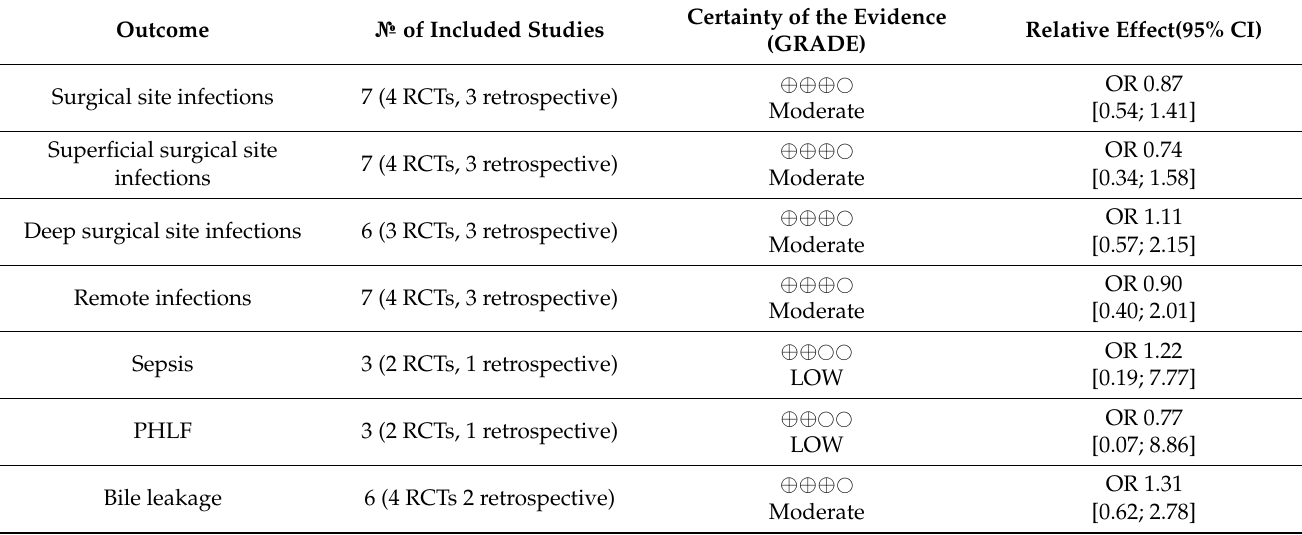
Table 5. Certainty of the evidence for outcomes of the main